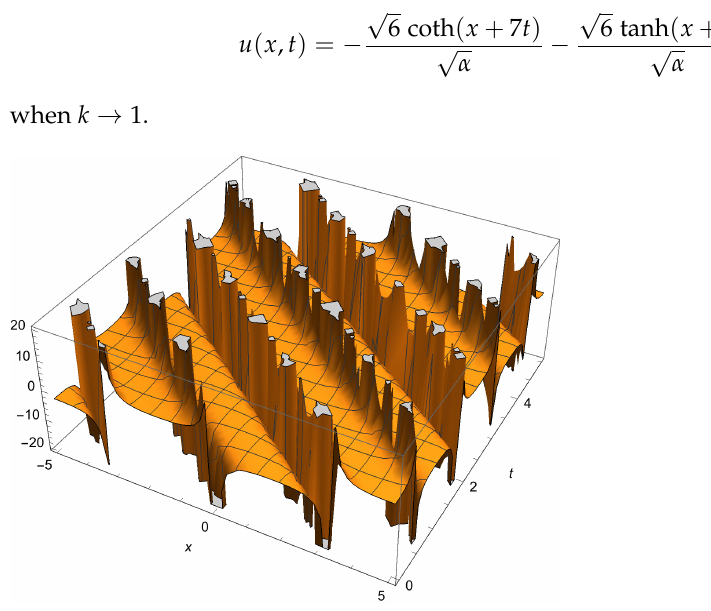
Figure 4. The 3D plot of the solutions (27) when k =